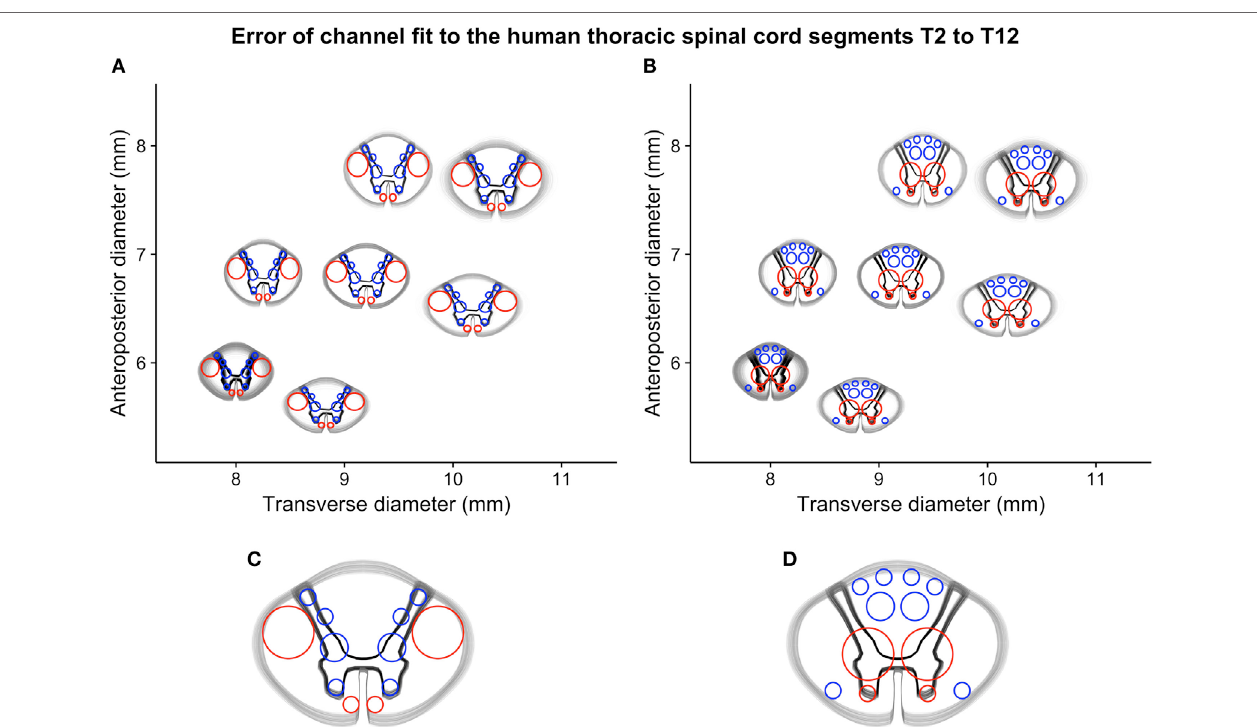
FigUre 6 | Simulated error-of-fit of guiding channels to thoracic spinal cord segments T2–T12: (a) all segments fitted to the best-fitting cranial interface, (B) all segments fitted to the best-fitting caudal interface, and (c) and (D) a detailed representation of both interfaces of the mid-sized guiding device (termed “normal 2”), showing the small deviation between guiding channels and intended position on the spinal cord